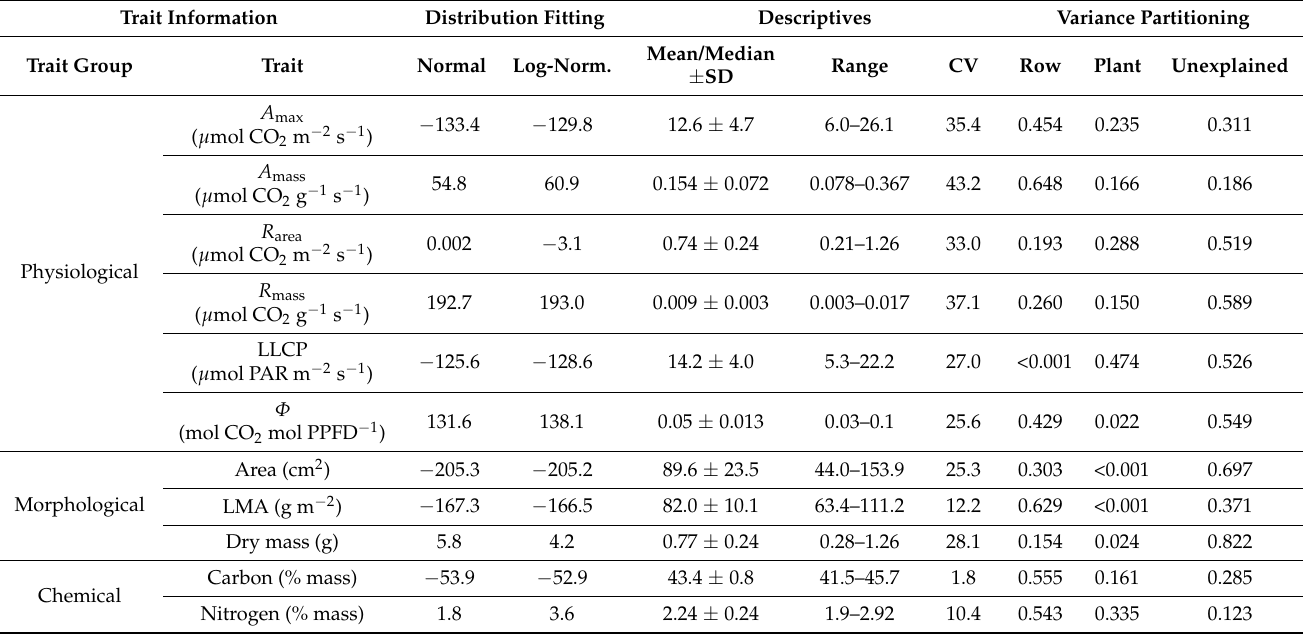
Table 1. Descriptive statistics for 11 leaf functional traits from 45 ‘Chardonnay’ leaves, measured in 2020 on 15 individual vines growing at a single site, across a soil compaction gradient. Trait Information Distribution Fitting Descriptives Variance